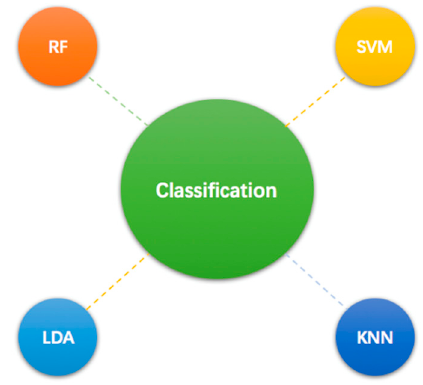
Figure 13. Classification models.